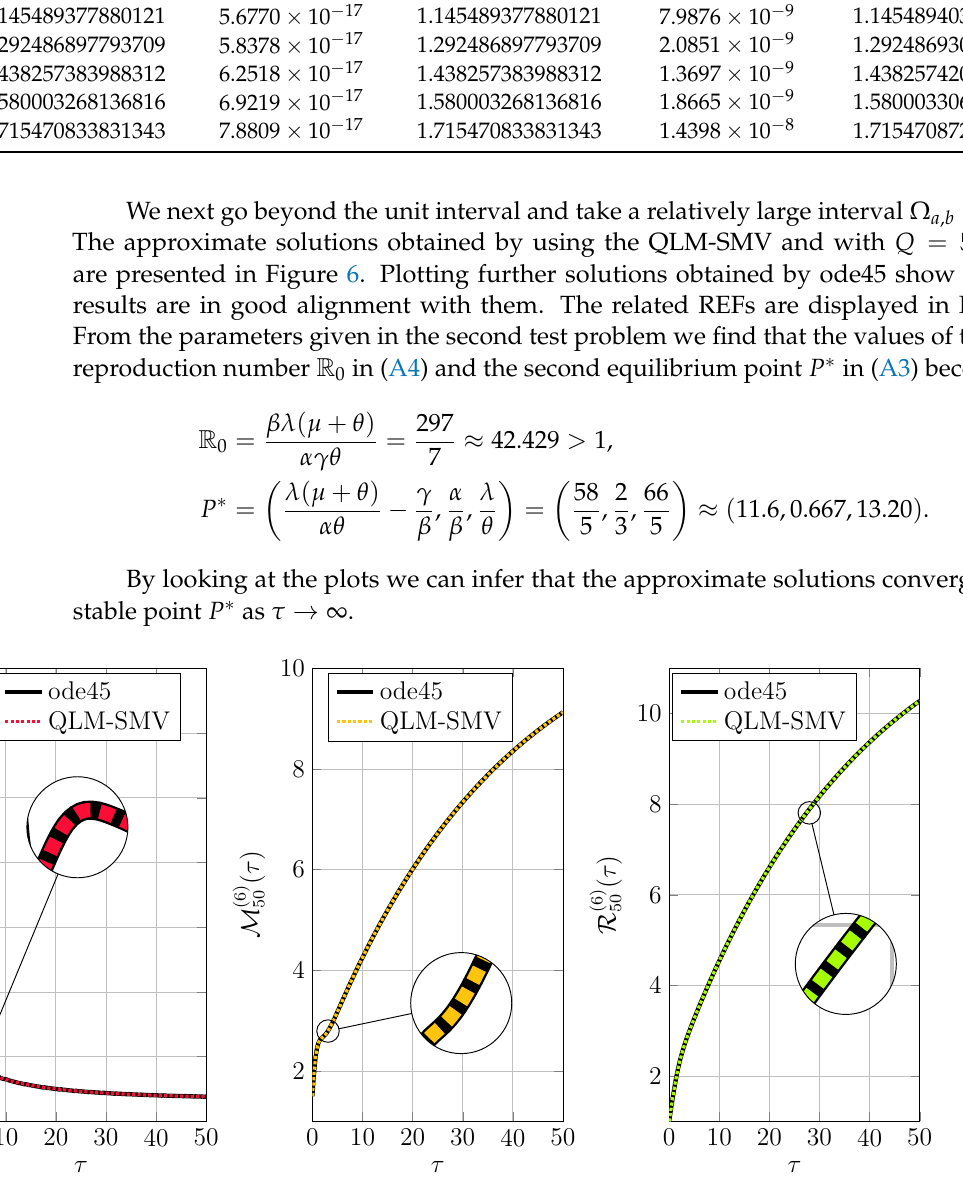
( τ ) in SMV/QLM-SMV procedure using Q = 10 R